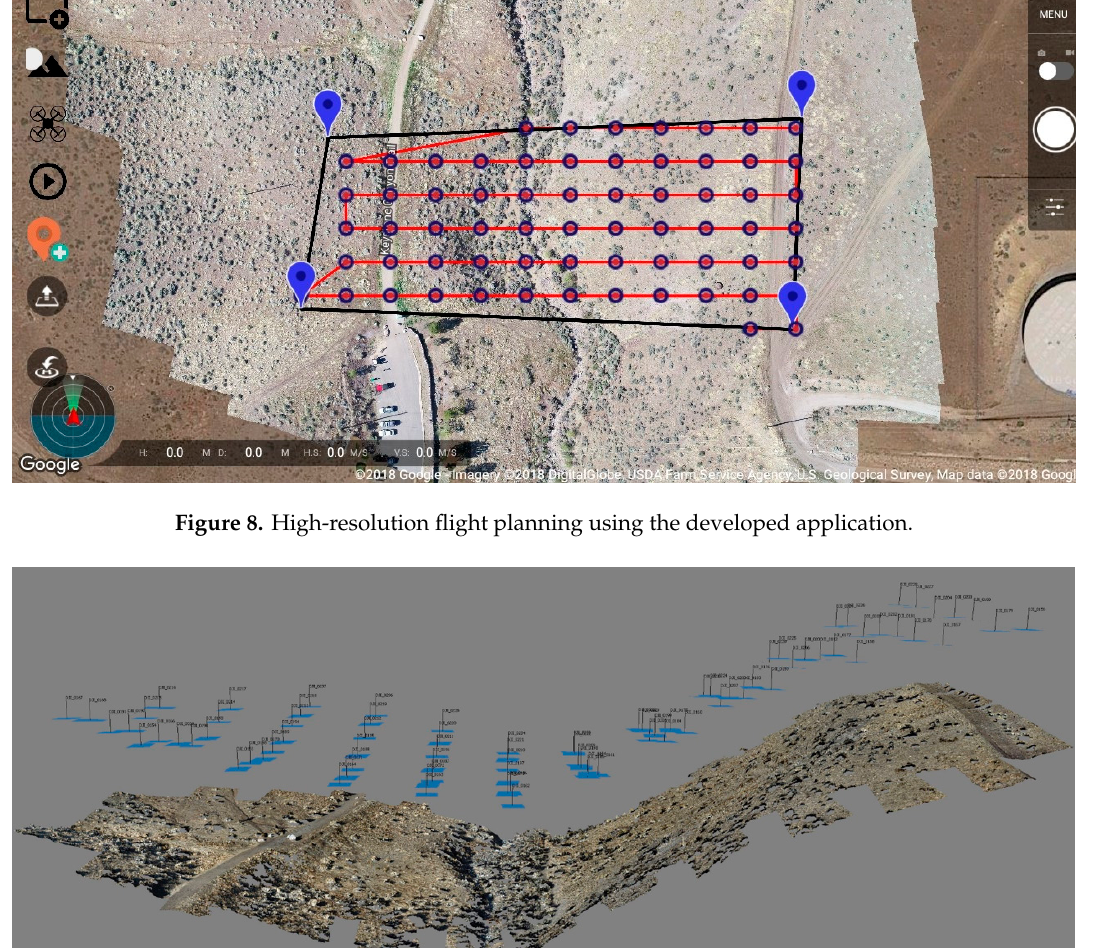
Table 2. Flight parameters for Stage 1 and Stage 2 flight test.